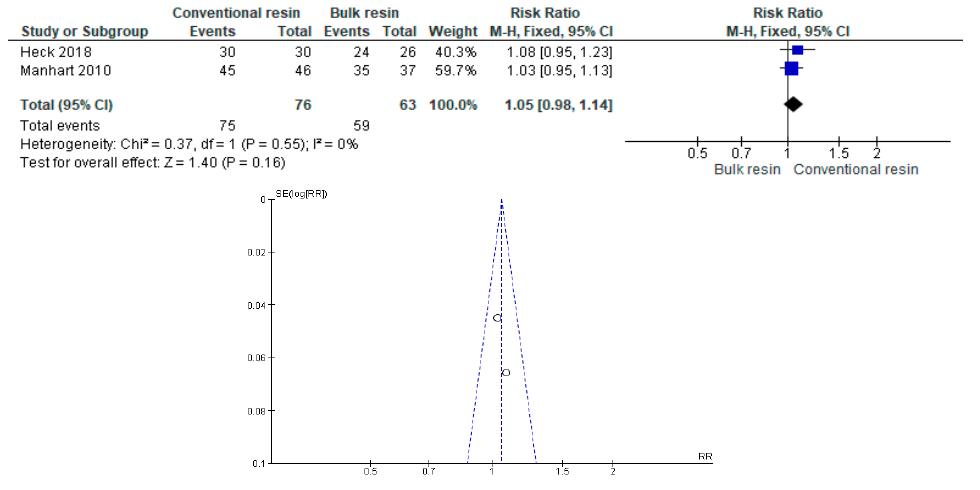
Figure A46. Proper Occlusion: Conventional Resin versus Bulk Resin.